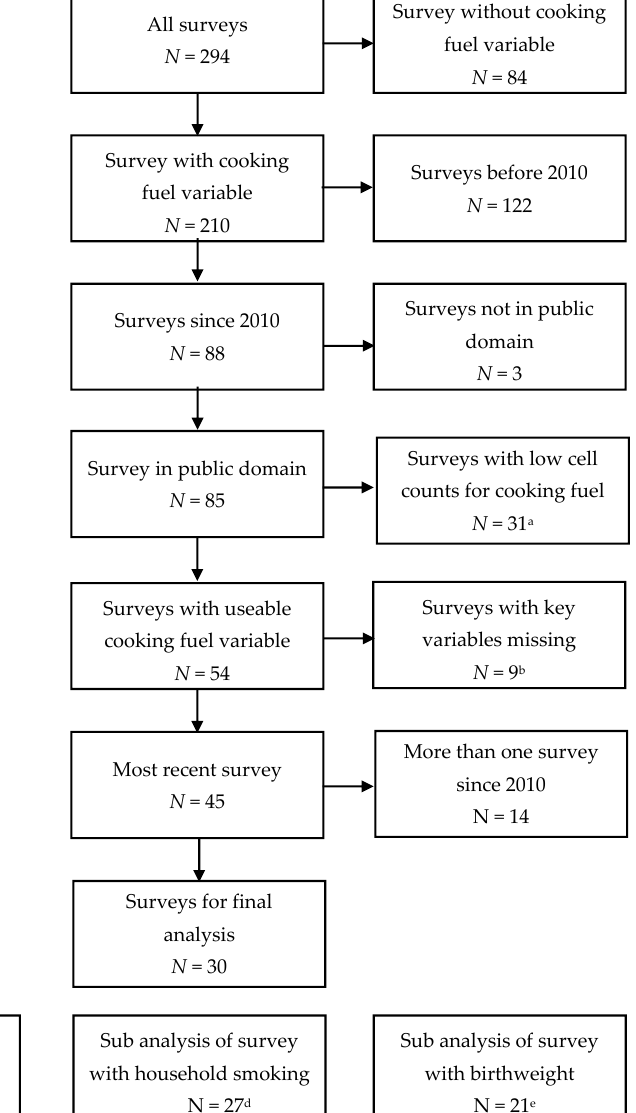
Figure A1. Flow diagram for selection of final dataset for analysis from all household data sets available from the DHS program data archive [31] ( a ) Survey was excluded due to have low cell counts for wood or charcoal cooking ( n = 31) included: Comoros